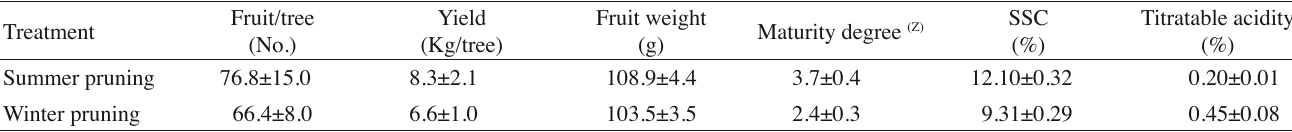
Table 2 - Effect of two-successive-year summer pruning on peach fruit yield and quality in the following season (2002)